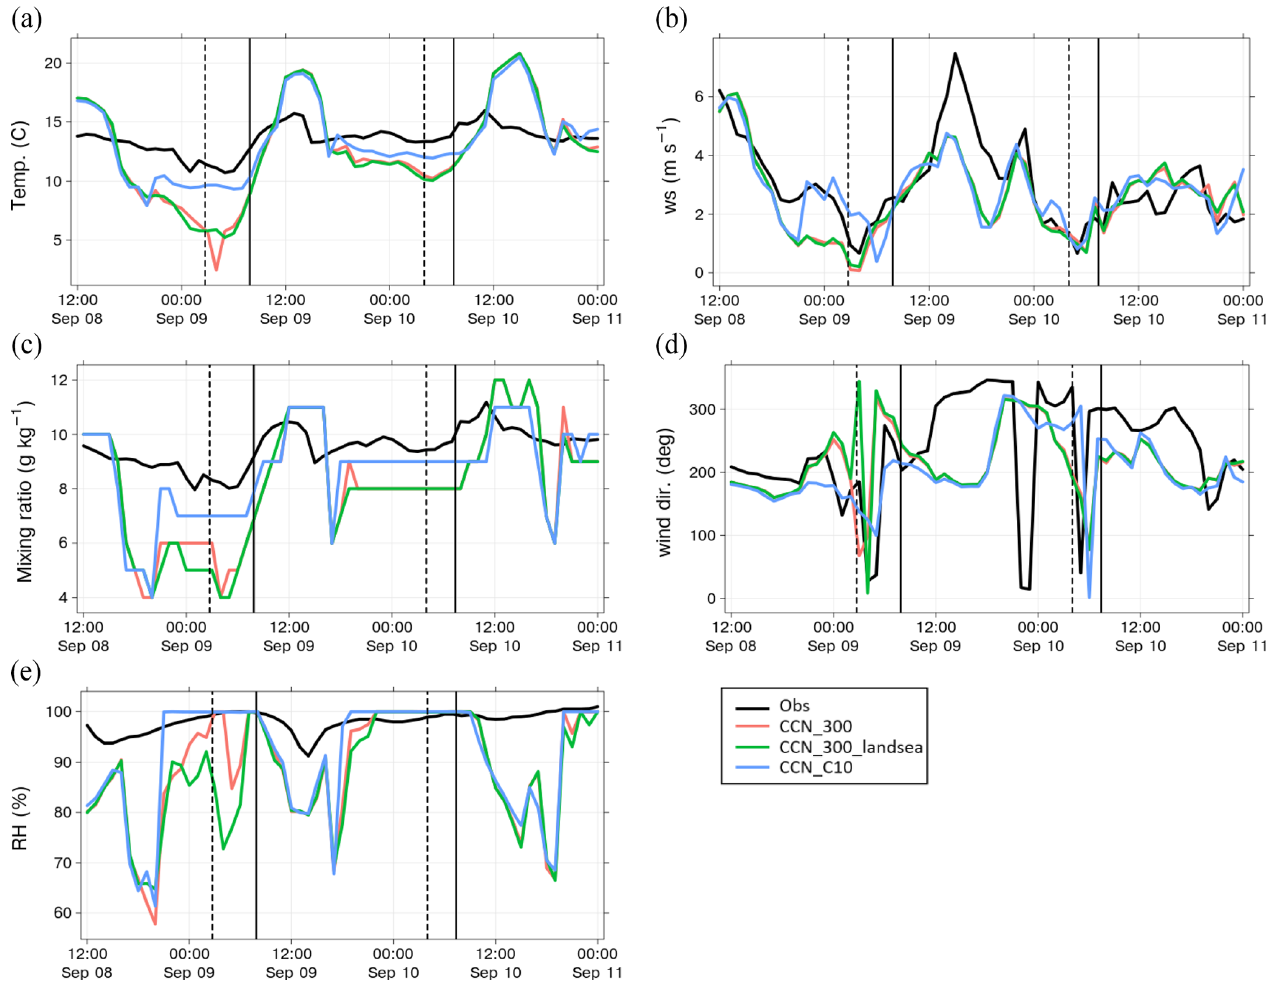
Figure 7. Time series of model and observed meteorological variables at Henties Bay for (a) temperature, (b) wind speed, (c) water vapour mixing ratio, (d) wind direction, and (e) relative humidity. Times are in UTC (site is UTC +